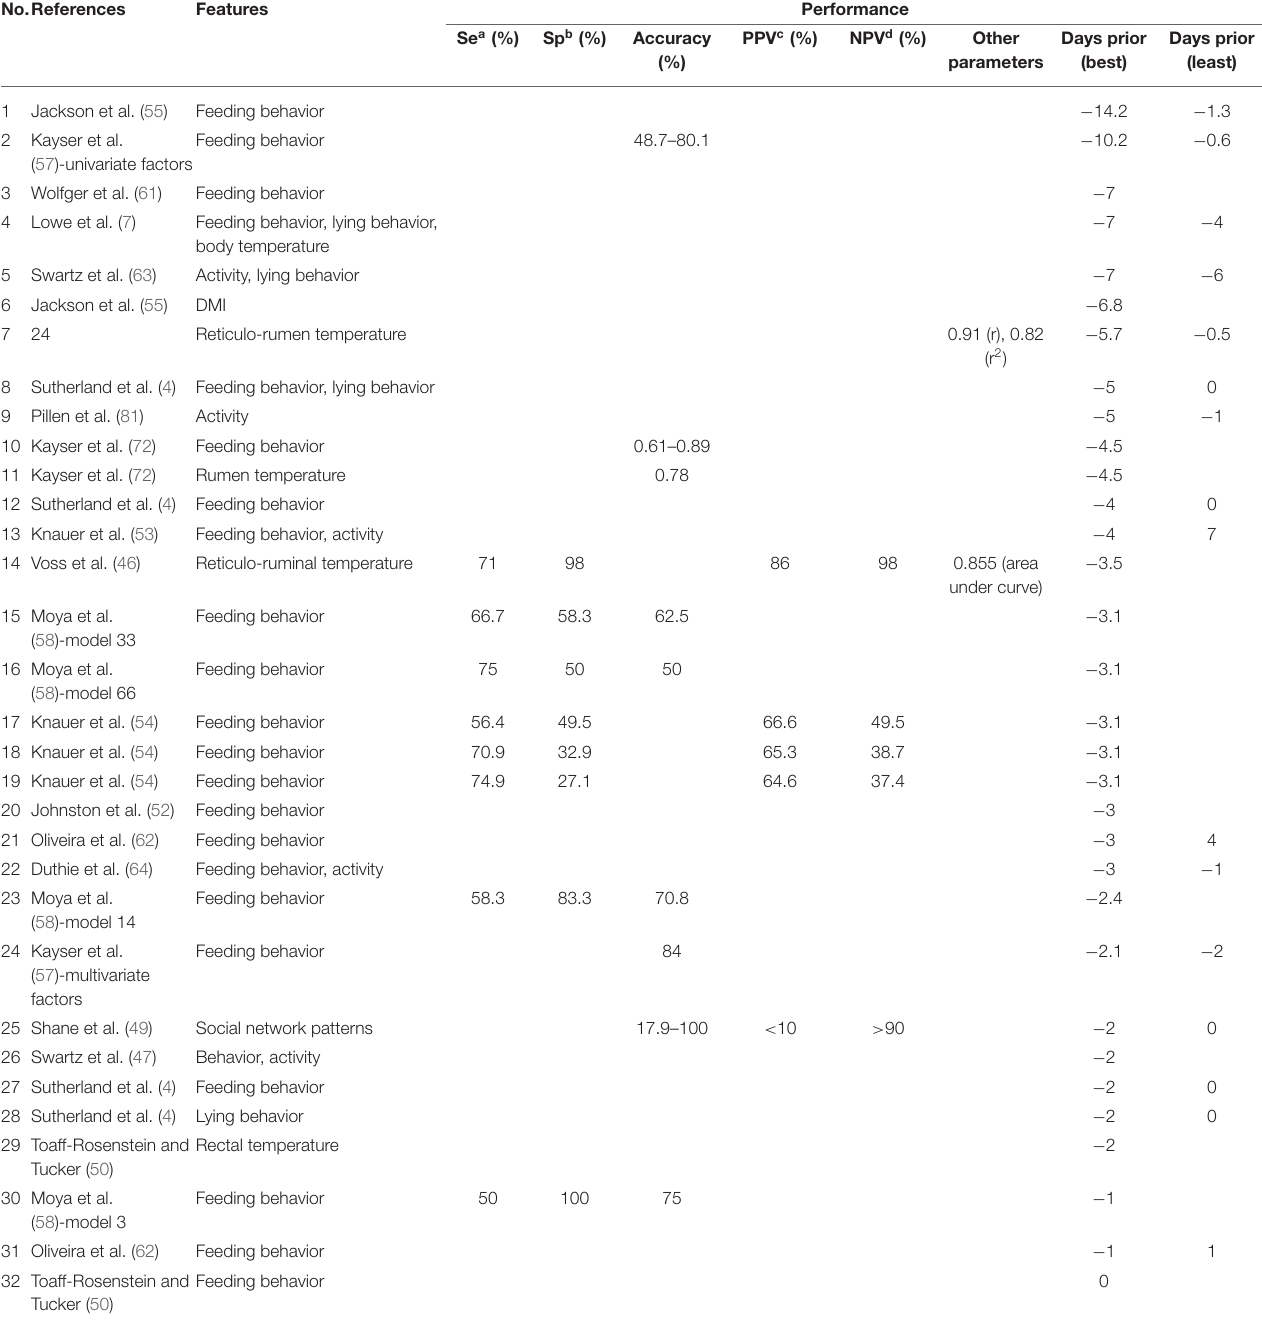
TABLE 3 | Performance of algorithms and